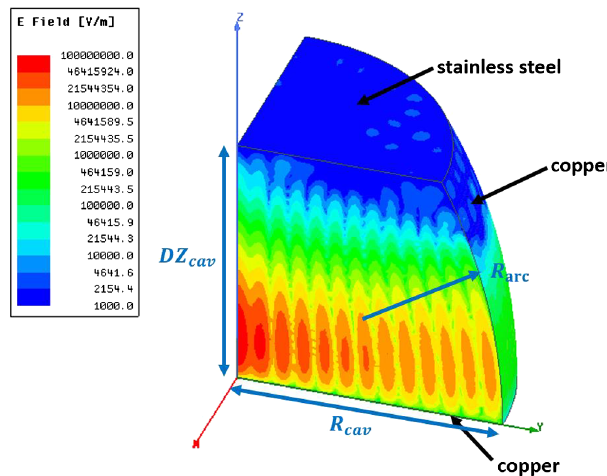
FIG. 2. Electrical field of the bowl-shaped open cavity operat- ing at TE 1 ; 2 ; 13 at 11.994 GHz. One quarter model of the cavity with a storage energy of 1 J was simulated by the eigenmode solver of high-frequency structure simulator (HFSS) [33]. The electrical field is in logarithmic